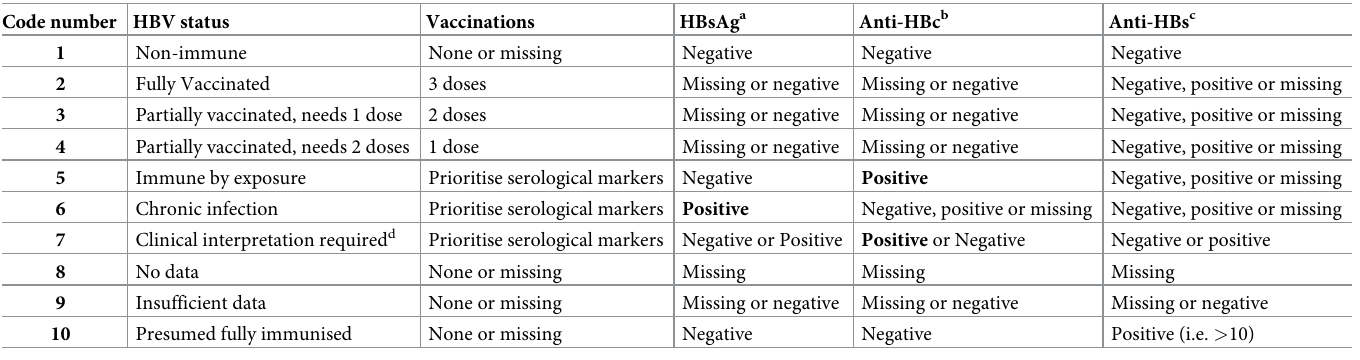
Table 2. HBV coding numbers and computerised algorithm for determining HBV